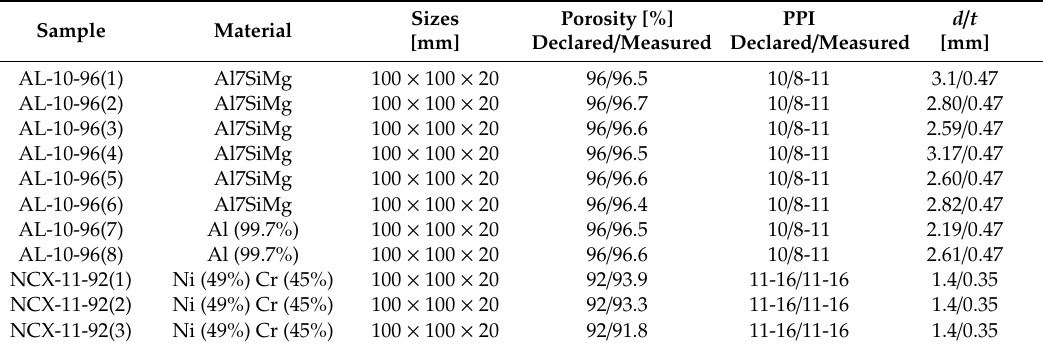
Table A1. List of the main characteristics of the tested metallic foam samples.